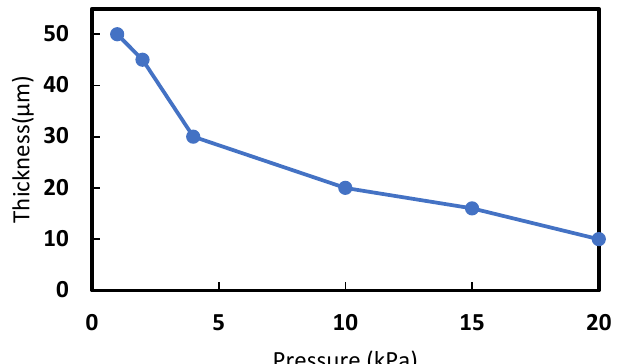
Figure 2. Evolution of the thickness of simulated composites for different applied pressures on the polymer composite.